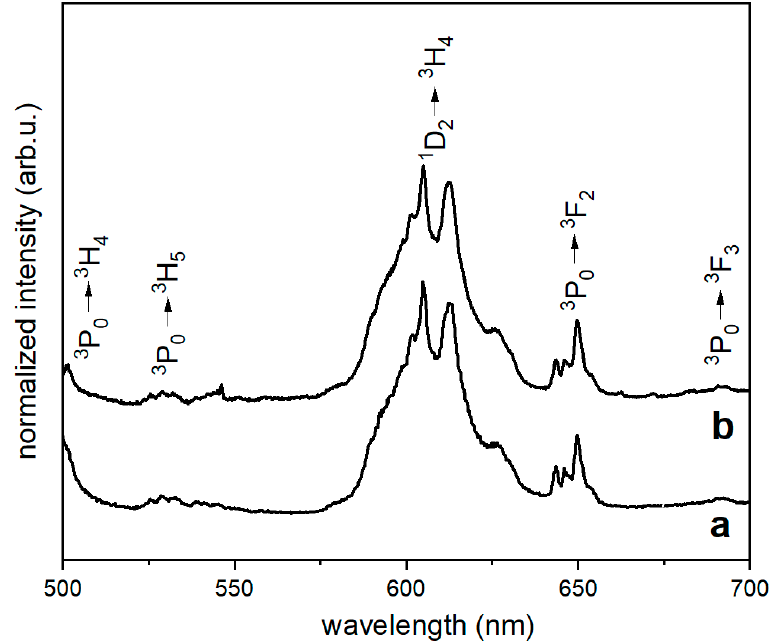
Figure 5. Emission spectra of PLLA with β -TCP co-doped with Ce 3 + and Pr 3 + ions ( a ) and PLLA with β -TCP composite with phosphate:polymer 1:20 ratio ( b ). Spectra were recorded after excitation with 445 nm.